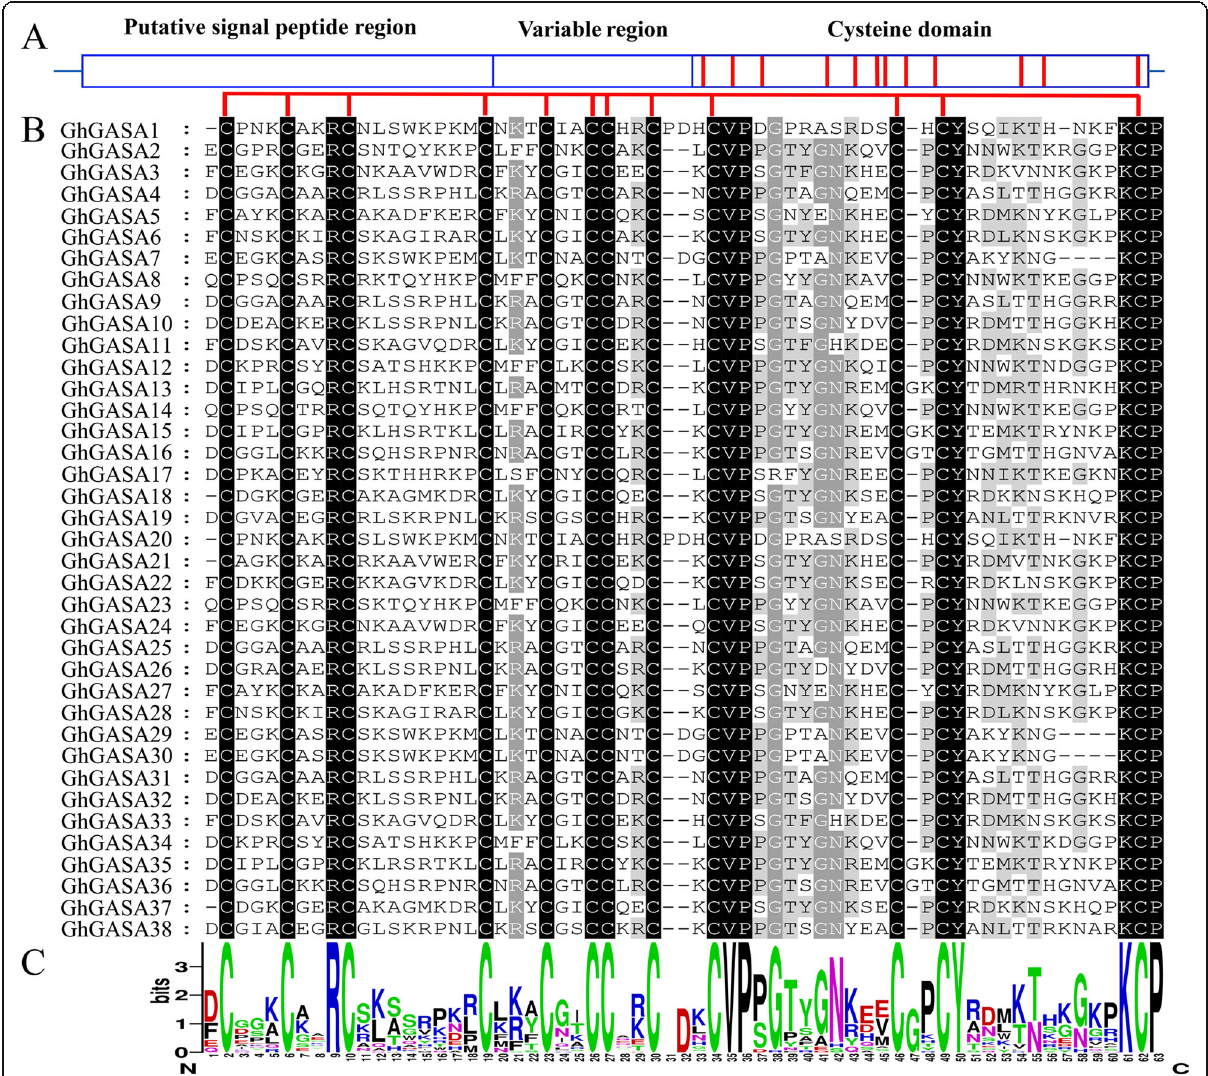
Fig. 1 Features of the GhGASA protein domains. a GhGASA protein structure analysis; the 12 cysteines are shown in the red column. b Multiple sequence alignments of the GhGASA conserved-domain. c Sequence logo of the GhGASA conserved-domain. Alphabets in each sequence represents amino